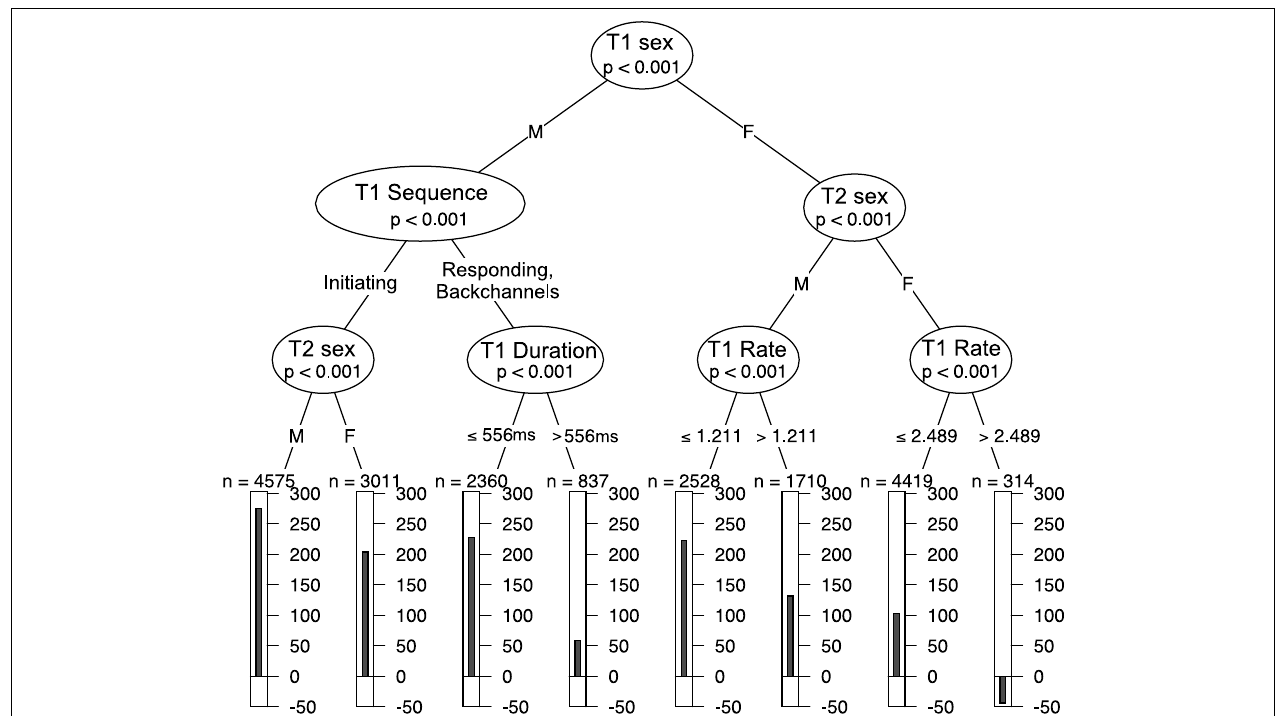
FIGURE 2 | A decision tree splitting data into gaps and overlaps by measures of sequence organization and